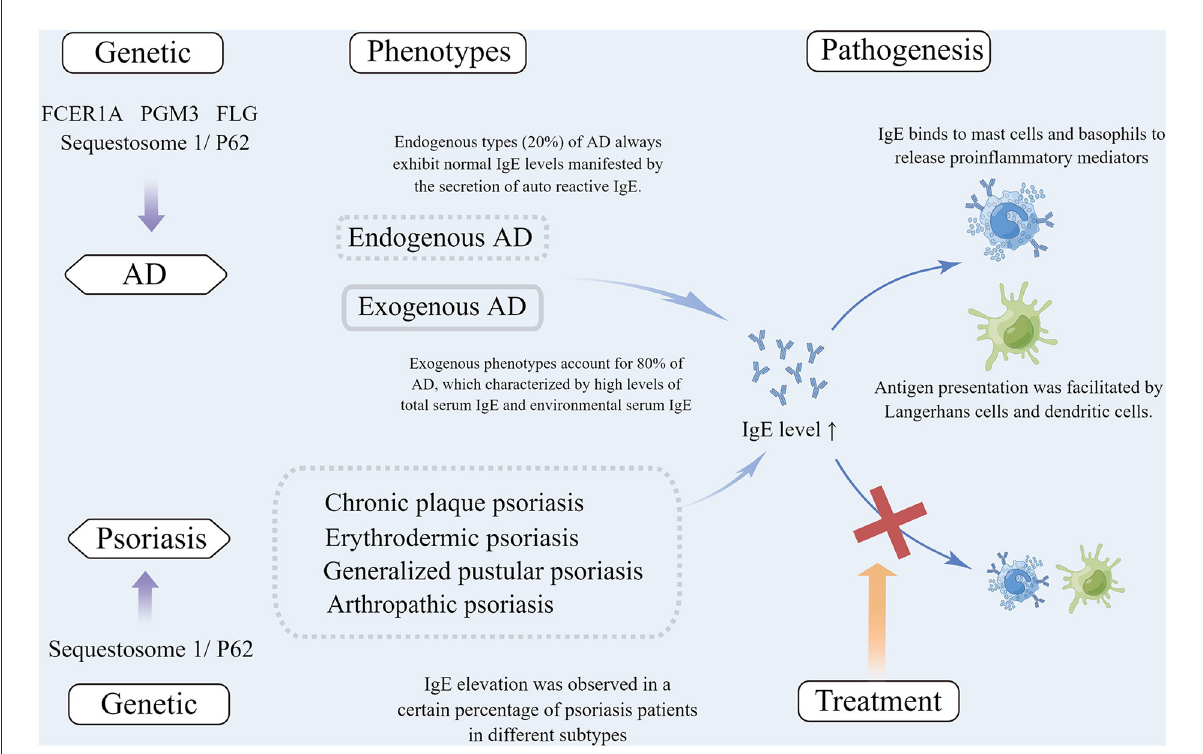
FIGURE1 (1) Mutations of several genes are associated with IgE elevation in atopic dermatitis, including FCER1A, PGM3, FLG and Sequestosome 1/P62, among which Sequestosome 1/ P62 mutation was also observed in psoriasis patients with elevated IgE; (2) Exogenous phenotypes account for 80% of patients with AD, which are characterized by high total serum IgE and allergen-specific IgE. Patients with endogenous types (20%) of AD always exhibit normal IgE levels manifested by the secretion of autoreactive IgE. IgE elevation was observed in a certain percentage of patients with different subtypes of psoriasis; (3) In the pathogenesis of AD, IgE binds to immune and non-immune cells that expressed high-affinity IgE receptors (Fc ε RI) (e.g., dendritic cells, Langerhans cells, mast cells, basophils, and keratinocytes) to release proinflammatory mediators or to facilitate antigen presentation. In psoriasis, IgE can be bound to the above cells that expressed high-affinity receptors to be involved in the pathogenesis; (4) Anti-IgE treatment is often effective in AD patients, but there are no reports concerning anti-IgE treatment for psoriasis.